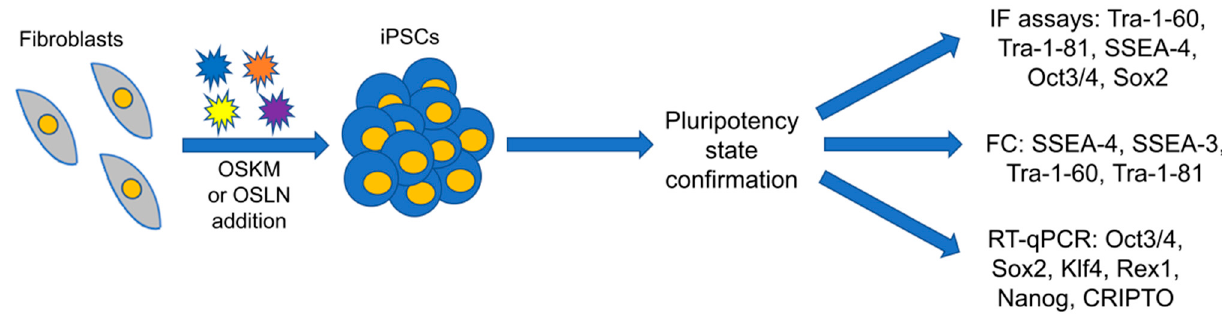
Figure 2. Schematic presentation of somatic cells reprogramming into iPSCs and pluripotency analysis. The generation of iPSCs from fibroblasts and the pluripotency state confirmation are presented. The most commonly used markers of pluripotency are shown. OSKM, Yamanaka factors (Oct3/4, Sox2, Klf4, c-Myc); OSLN, Thomson factors (Oct3/4, Sox2, Lin28a, Nanog); iPSCs, induced pluripotent stem cells.